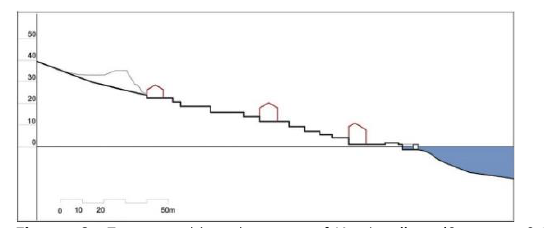
Figure 3. Terraced landscape of Kostanjica (Source: